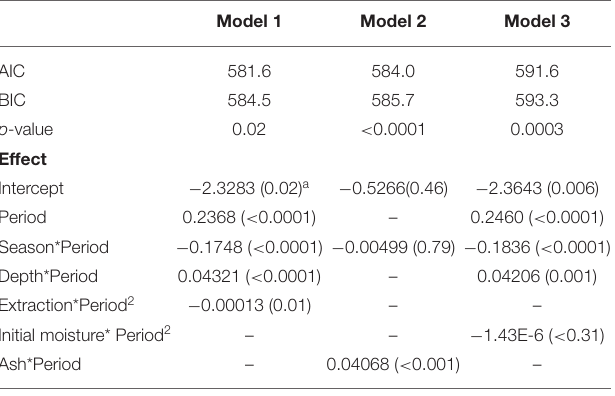
TABLE 9 | Coefficients of two non-linear models that predict dry matter loss of hot water extracted chips (HC) and fresh chips (FC) when stored in outdoor summer and winter pile, and Akaike Information Criterion (AIC) and Bayesian Information Criterion